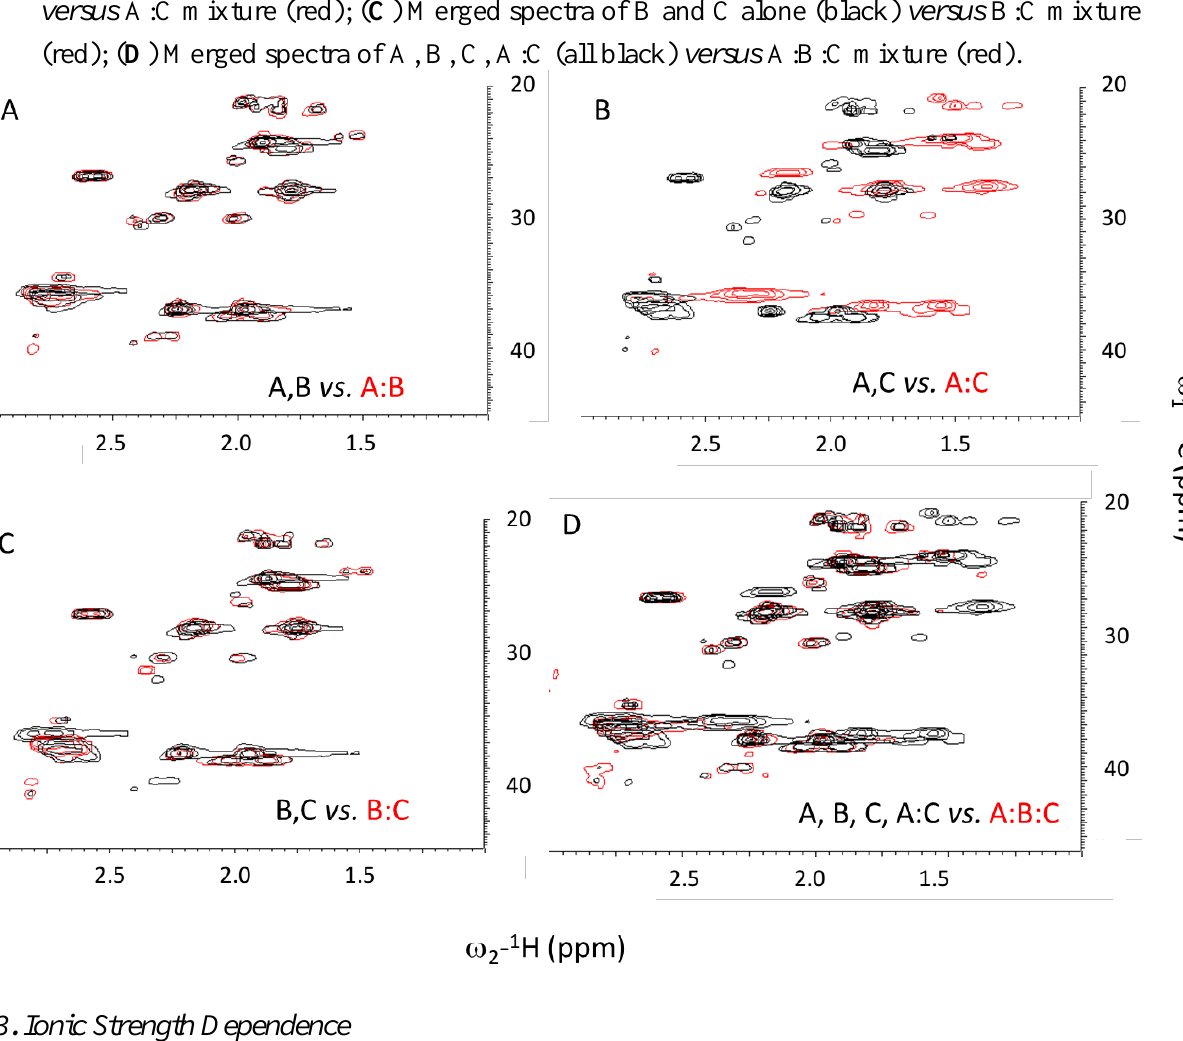
Figure 3. NMR measurement of 1 H- 13 C HSQC spectra. ( A ) Merged spectra of A and B alone (black) versus A:B mixture (red); ( B ) Merged spectra of A and C alone (black) versus A:C mixture (red); ( C ) Merged spectra of B and C alone (black) versus B:C mixture (red); ( D ) Merged spectra of A, B, C, A:C (all black) versus A:B:C mixture